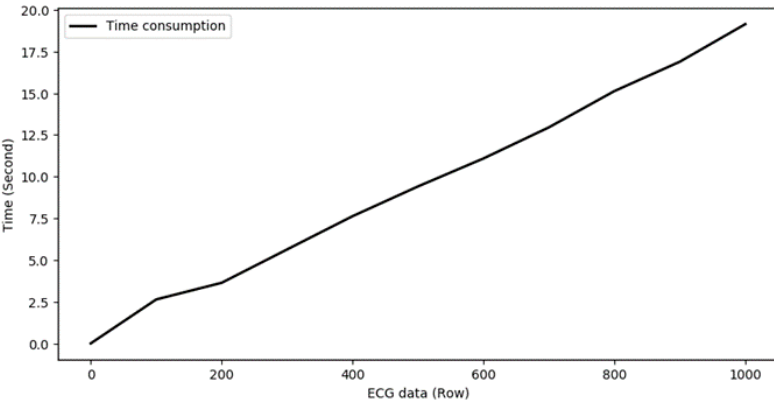
Figure 9. The time consumption as the amount of ECG data increases.